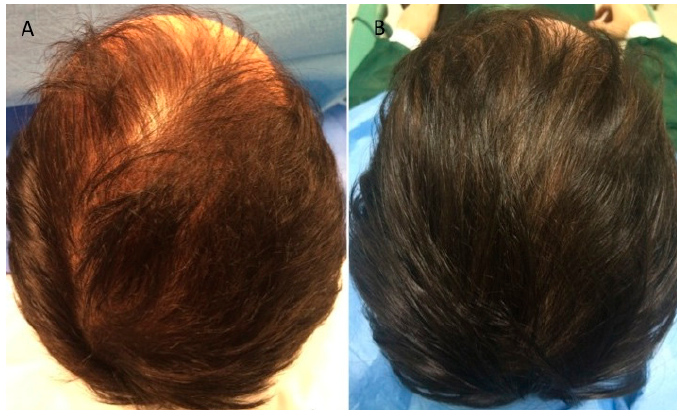
Figure 3. Clinical case of a male patient affected by androgenetic alopecia. ( A ) Pre-operative situation of the frontal, temporal and parietal; ( B ) Post-operative situation after three A-PRP injections with increase in the hair count and hair density.